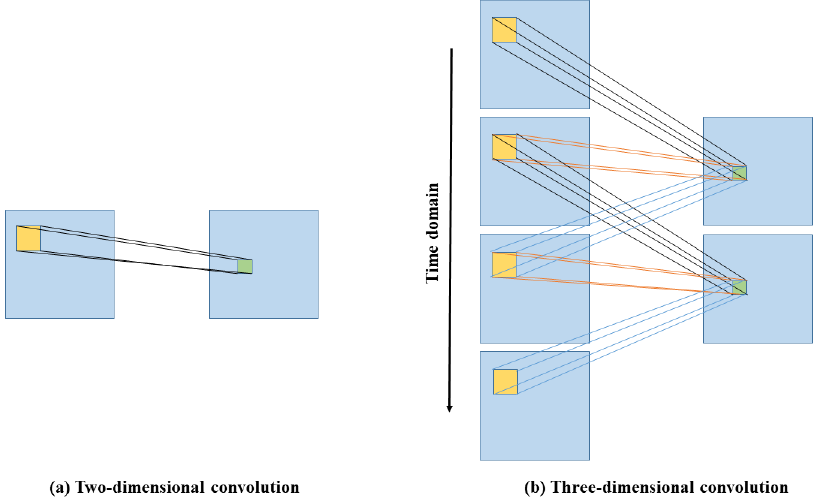
Figure 4. Comparison of 2D ( a ) and 3D ( b ) convolutions. In 3D convolution, the same 3D kernel is applied to overlapping 3D cubes in the input video to extract motion features.